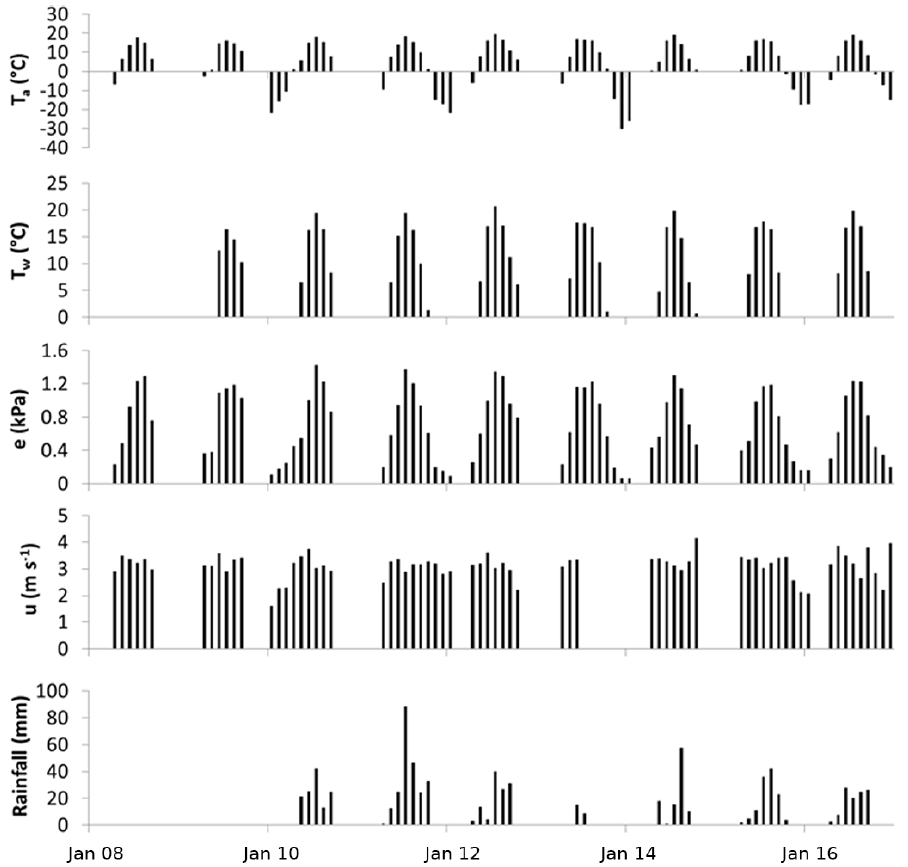
Figure 8. Monthly average meteorological conditions over Landing Lake in 2008–2016. T a and T w denote air and surface-water temperature, respectively. Vapour pressure is e , and u is wind